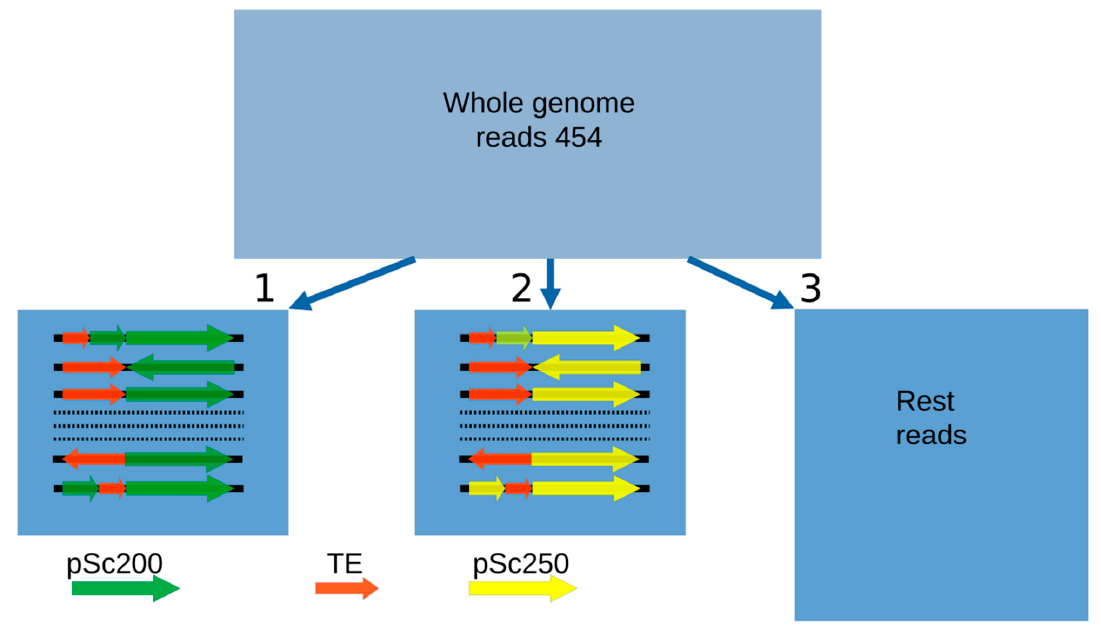
Figure 1. Three sets of 454 reads used for profiling TE families: (1) in “non-tandem DNA-pSc200 tandem” junction regions, (2) in the “non-tandem DNA—pSc250 tandem” junction regions and (3) in the rest of the rye genome. By way of illustration, Rectangles 1 and 2 display different possible variants of the reads.